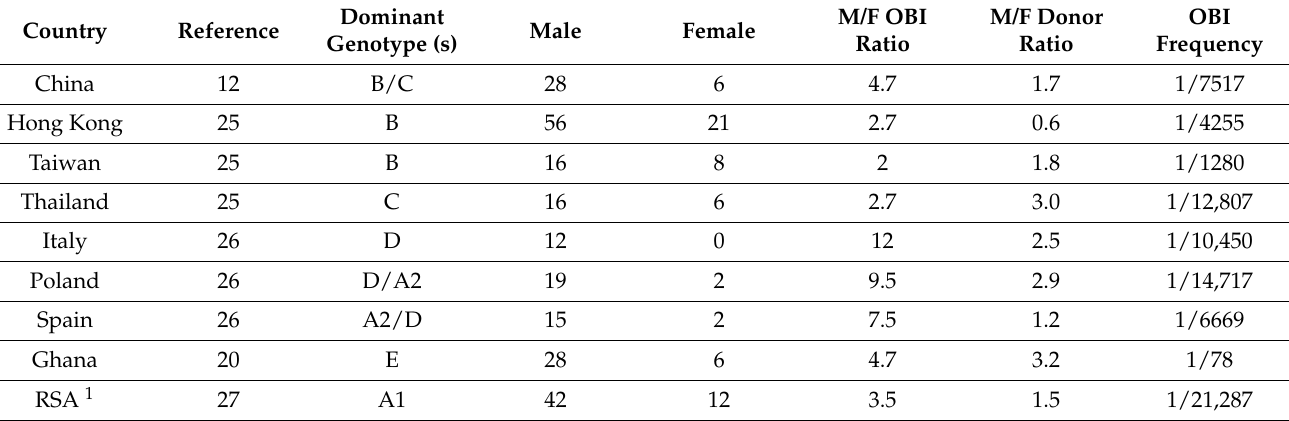
Table 1. Gender distribution in blood donor samples carrying OBI from different countries.